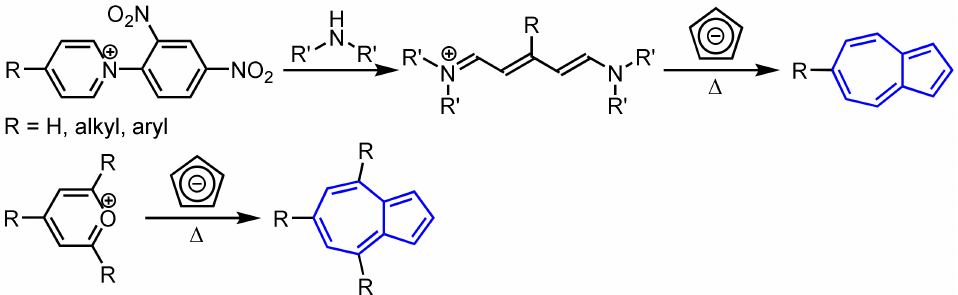
Scheme 2. Synthesis of azulenes from pyridinium and pyrylium